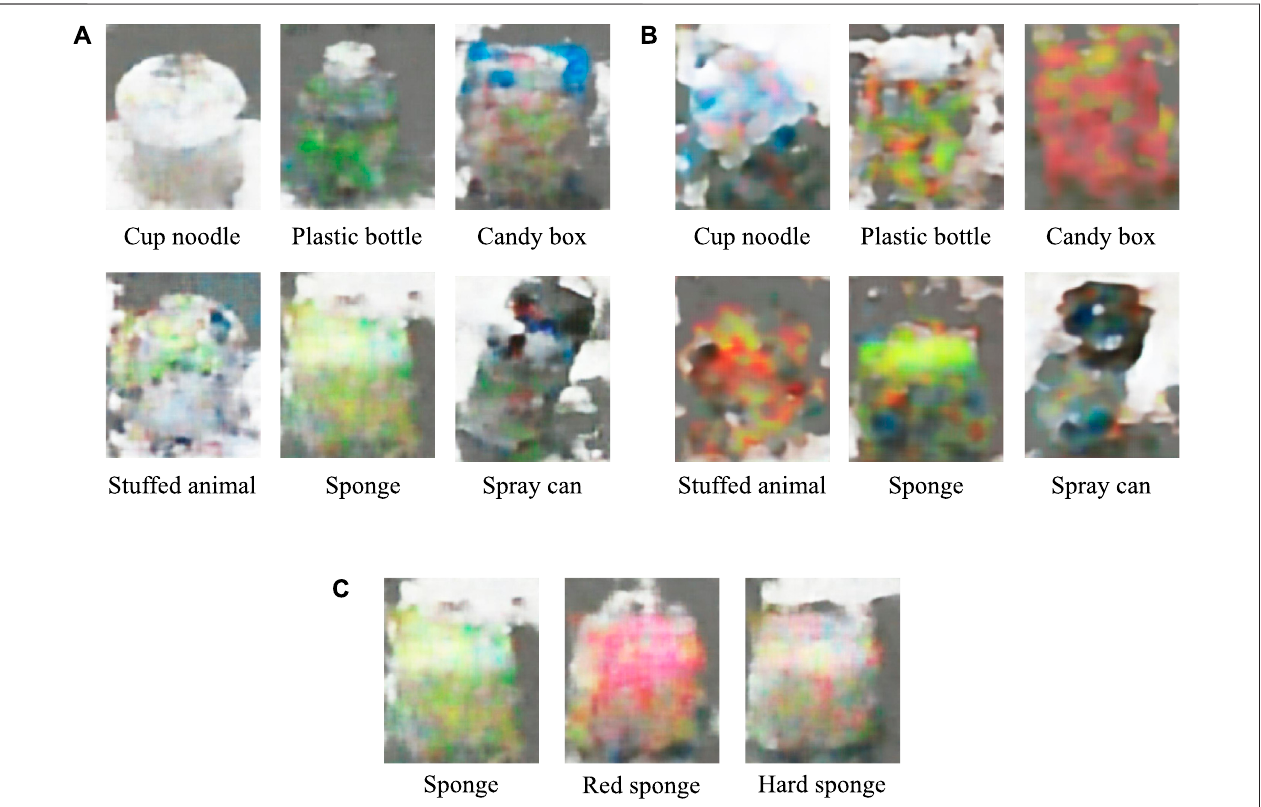
FIGURE 7 | Examples of images generated from words: (A) examples of MNVAE + MLDA, (B) examples of JMVAE, and (C) examples of images with changes owing to addition of adjectives.